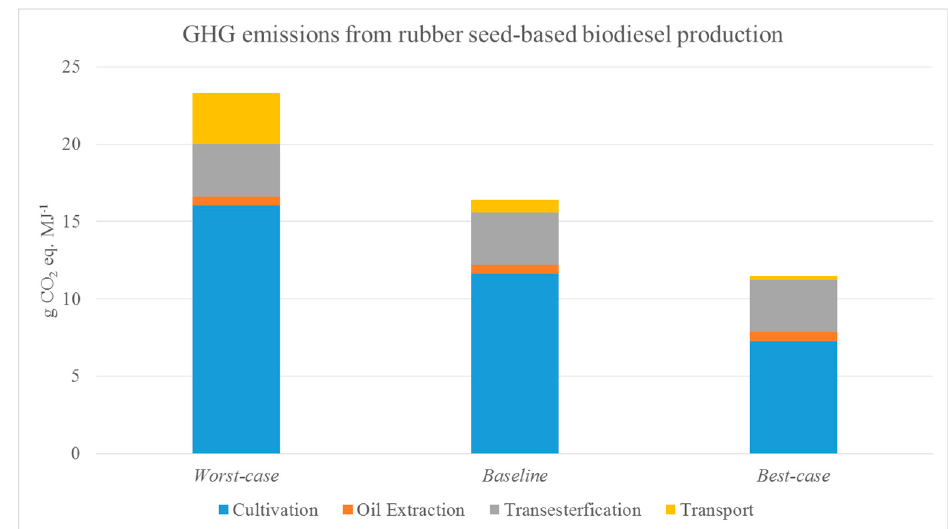
Figure 2 . GHG emissions from rubber seed-based biodiesel production in g CO 2 eq. MJ − 1 RSME for the worst-case , baseline and best-case scenarios.